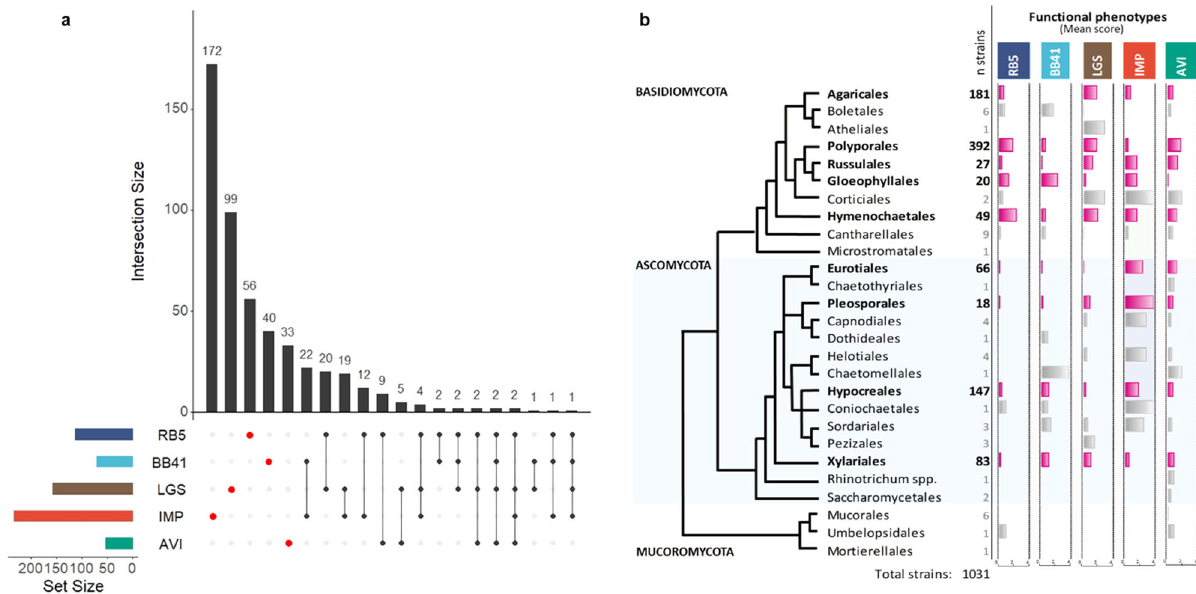
Fig. 4 Substrate-wise and phylogeny-wise distribution of the phenotypic scores of the 1031 tested fungal strains. a UpSet plots illustrating quantitative intersection of the sets of strains showing the highest score (score 4) for each functional phenotype (the colored bars on the left-hand side indicate the total number of strains that scored a 4 for each compound). For instance, looking at IMP, out of 233 “ score 4 ” strains, 172 scored a 4 exclusively on IMP (and not on any other compound), while 22 scored a 4 on both IMP and BB41. The fi gure shows that high scoring strains with a single phenotype represent the majority. b Mean scores of multi-phenotyping of 1031 natural strains belonging to 26 fungal orders mapped onto the phylogenetic tree. The numbers of analyzed strains ( n samples) are indicated in the fi rst column. Horizontal histograms show the mean scores for each fungal order for each phenotype, ranging from 0 to 4. Note that these scores re fl ect a functional phenotype (i.e., decolorization (RB5, BB41), oxidation (LGS), degradation (IMP), or growth (AVI)). Growth phenotypes for all strains/compounds couples are provided in Supplementary Data 2. Histograms colored in pink indicate orders for which more than ten strains were analyzed (otherwise shown in gray). The topology of the tree was built according to recent phylogenies of Fungi 57 – 59